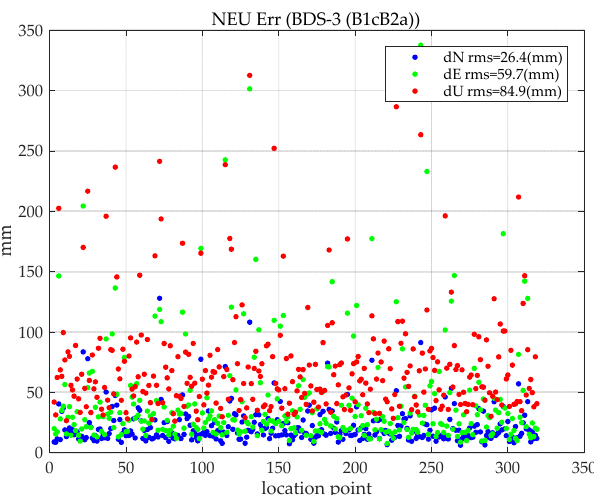
Figure 9. Kinematic BDS-3 (B1cB2a) PPP positioning RMS.